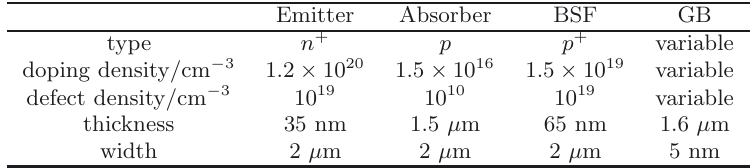
Fig. 1. Left: Structural model of the poly-Si solar cell unit composed of a p -type crystalline Si absorber grain (2 μ m width), p + back surface field and n + emitter with an adjacent vertical grain boundary layer (5 nm width). The contacts, defined as ohmic, are depicted in orange. The silicon nitride (SiN) top layer represents the antireflection coating. Right: Assumed defect distribution in the GB layer over the energy in the band gap for the particular case of a GB defect density of 10 17 cm − 3 eV − 1 . For details see Tables 1 and 2. Table 1. Parameters of the cell’s layers: emitter, absorber, BSF and